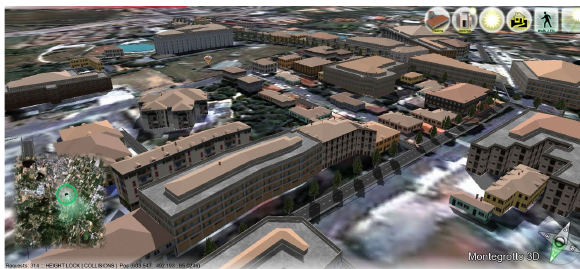
Figure 7. Montegrotto city with quad-tree hierarchy in OSG4Web